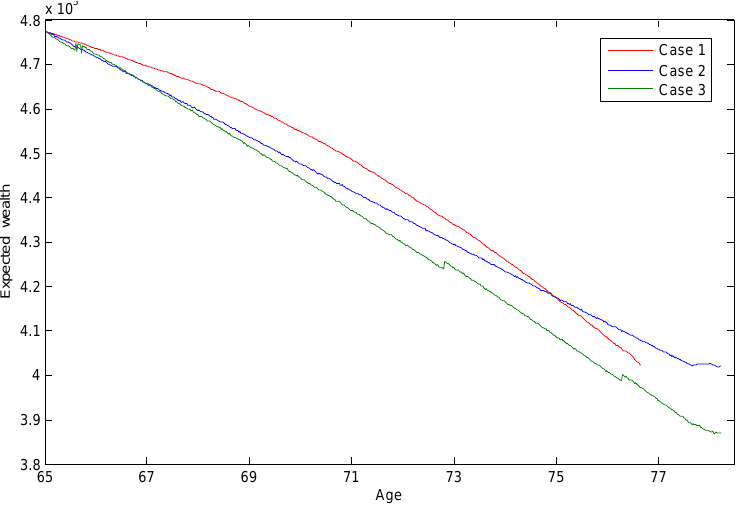
Figure 3. Expected wealth, truncated at optimal stopping times, for case 1, 2 and 3 agents commencing at age 65 in the healthy state with total wealth of 10 Y . Recall case 1 agents have no access to insurance markets, while case 3 agents replicate an American put option to ensure their savings target is